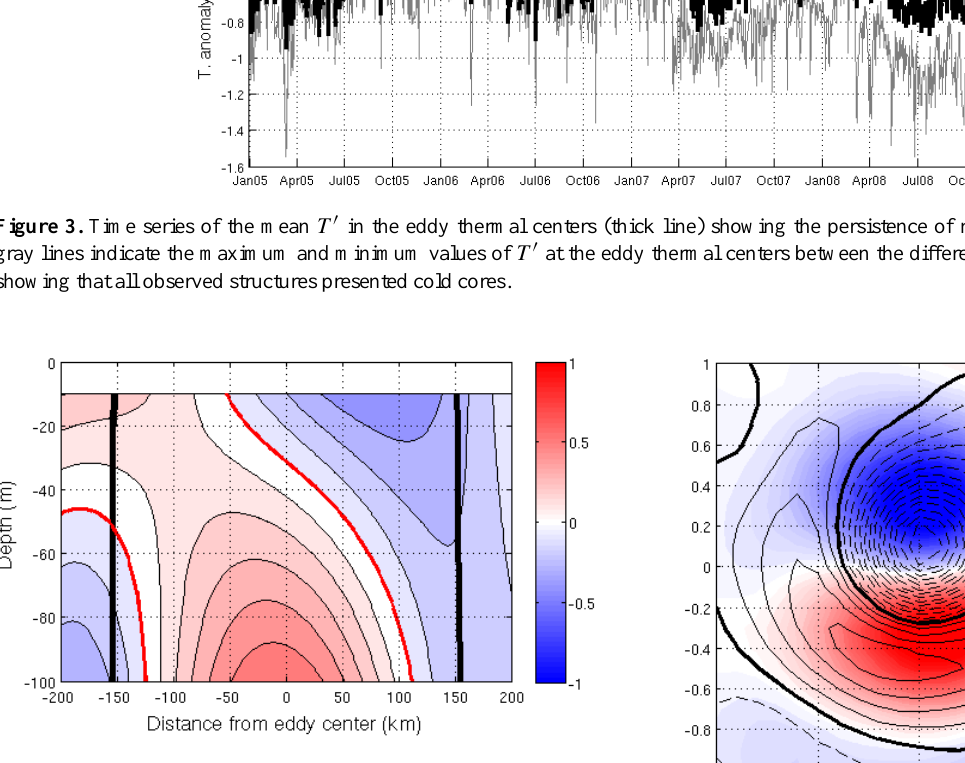
Figure 4. Top 100m of the Agulhas rings mean T 0 vertical structure (c.i. 0.1 ◦ C) obtained from the Argo float vertical profiles by Souza et al. (2011b) (c.i.: contour interval). The red contours indicate the 0 ◦ C T 0 , while the thick black lines delimit the water trapped region following the criteria by Flierl (1981). The cold (negative) T 0 dom- inates the eddy core near the surface, while the warm (positive) T 0 is shifted to the left (west).